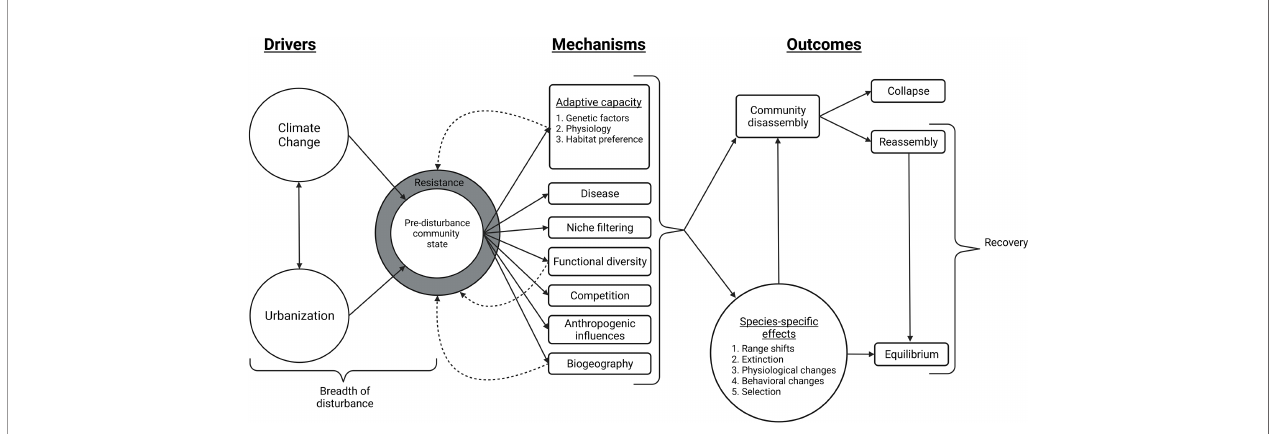
FIGURE 1 | In fl uence diagram representing community resilience, via the mechanisms by which different community-level outcomes may result from the chronic disturbances of climate change and urbanization, and their interactions. In this diagram, resistance is depicted through the breadth of disturbance and the underlying mechanisms of community response, while recovery occurs through community reassembly and/or when a given community reaches a state of equilibrium. Resistance is a buffer against disturbance that allows for community persistence until it is overcome by the breadth of disturbance. Mechanisms such as adaptive capacity, functional diversity, and biogeography can contribute to resistance and/or recovery by returning a community to its pre-disturbance state when resistance is overcome (illustrated by dotted arrows). This diagram is not a comprehensive illustration of mechanisms and outcomes, but instead depicts those that are commonly associated with climate change and urbanization. These outcomes are also not fi nite, climate change and urbanization will continue to operate on reassembled and alternative communities through these mechanisms, producing later community disassembly, reassembly, and alternative stable states (Created with